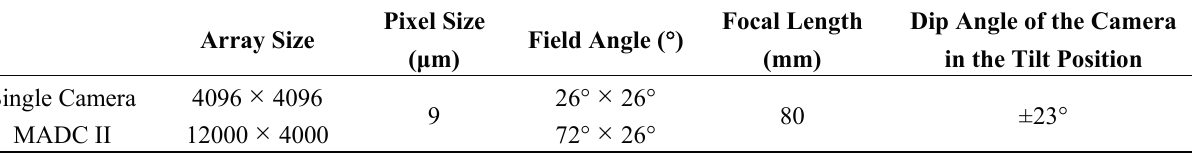
Figure 13. Rendering image of the generated DEM. Table 7. Parameters of TSC and prototype